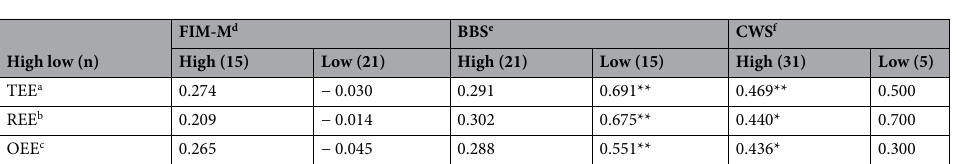
Table 4. Correlation coefficient between high and low levels of physical function and each energy expenditure (Spearman’s rank correlation coefficient). **p < 0.01, *p < 0.05. a Total energy expenditure per day. b Energy expenditure during rehabilitation. c Energy expenditure except during rehabilitation. d Functional Independence Measure Motor score. e Berg Balance Scale. f 10-m comfortable walking